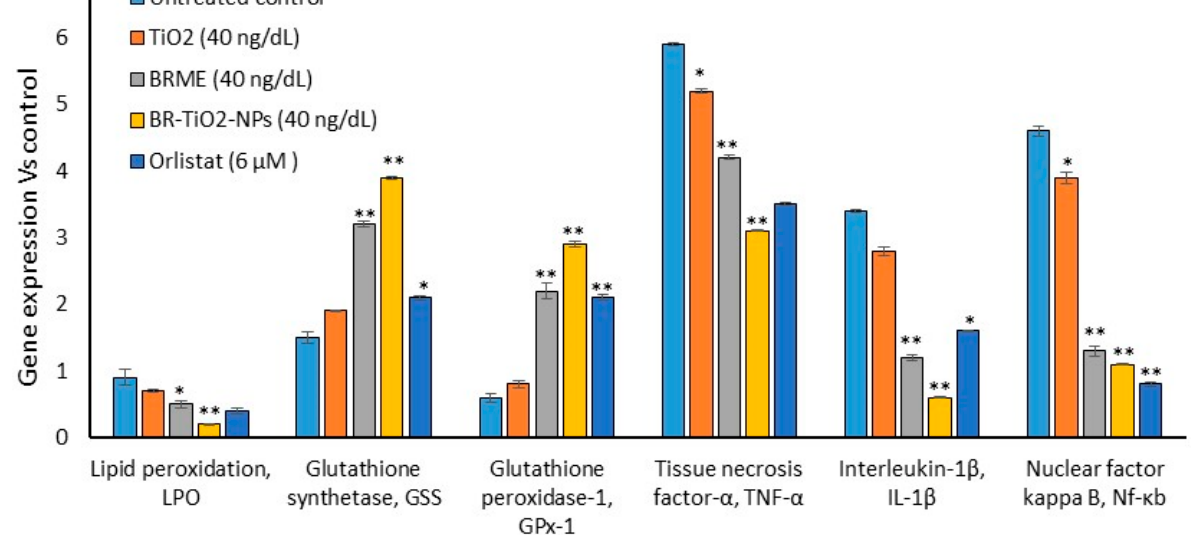
Figure 4. Oxidative stress and antioxidant-related gene expressions in the untreated control, TiO 2 , BRME, BR-TiO 2 -NPs, and orlistat-treated hMSC after 48 h. Each value is a mean ± SD ( n = 6). * Significant at p ≤ 0.05 and ** highly significant at p ≤ 0.001, by comparison with the untreated control.